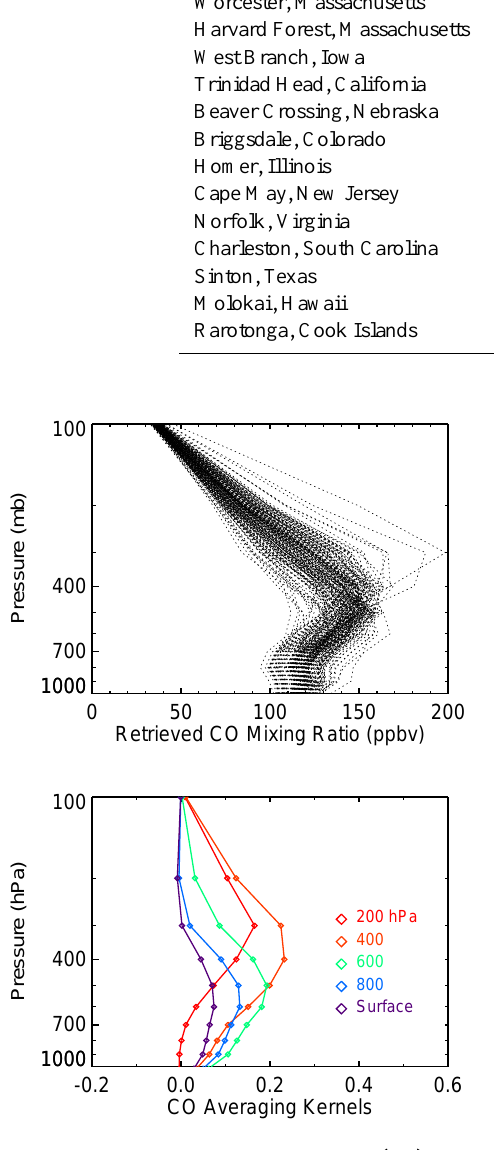
Figure 2. V6 TIR-only retrieved CO profiles (top) and associ- ated mean averaging kernels (bottom) for observations obtained on 10 April 2010 between 20 and 24 ◦ N, 160 and 156 ◦